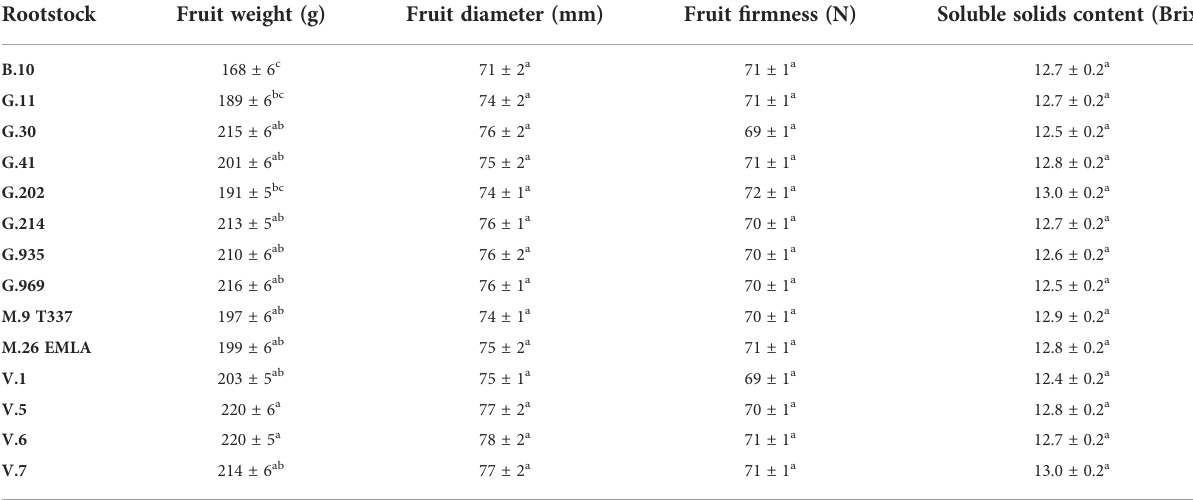
TABLE 1 Effect of different rootstocks on fruit weight, diameter, fi rmness, and soluble solids content of ‘ Honeycrisp ’ apples.